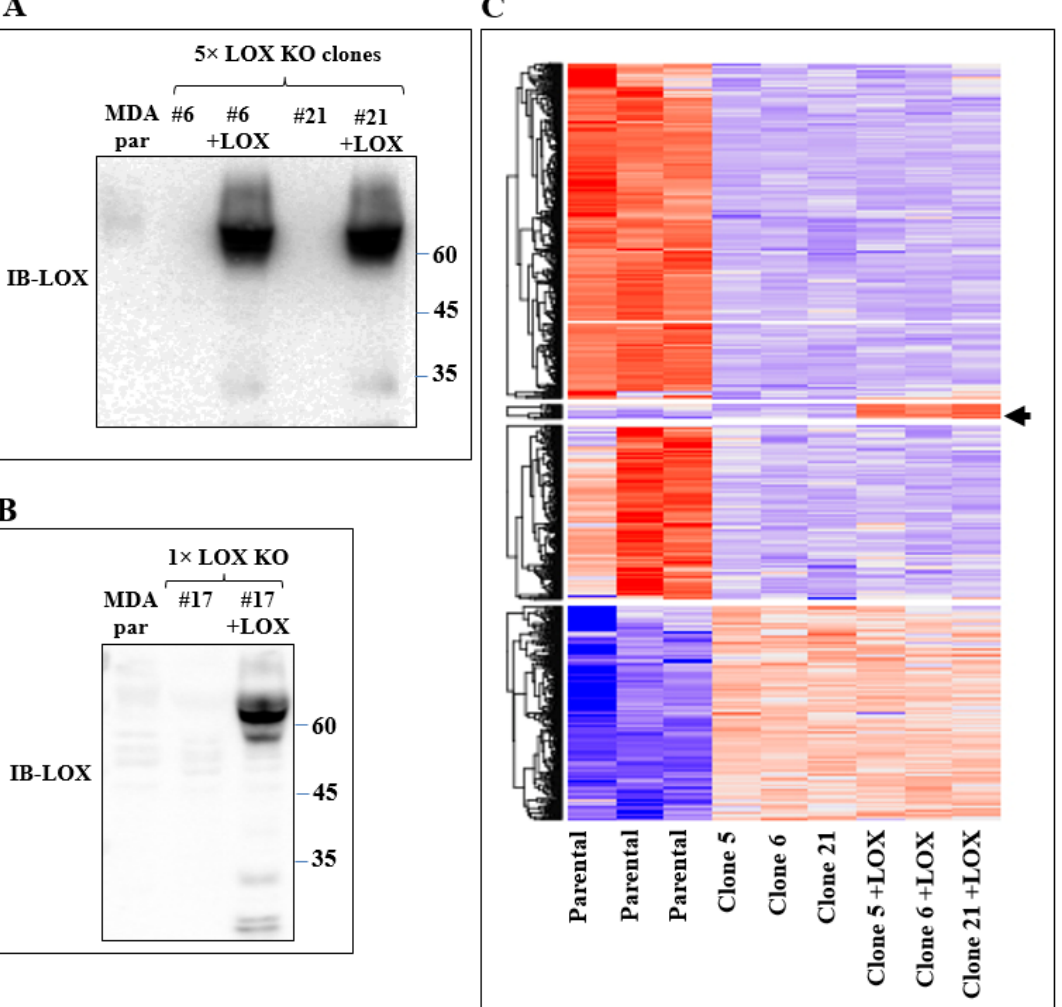
Figure 2. Re-expression of LOX in 5× knock-out clones resulted in changes in gene expression. ( A ) Western blot analysis using anti-LOX antibodies of equal volumes of conditioned medium of confluent MDA-MB-231 cells (MDA par), clone 6 and clone 21 cells and of these cells following LOX cDNA re-expression. ( B ) Western blot analysis using anti-LOX antibodies of equal volumes of conditioned medium of confluent MDA-MB-231 cells (MDA par) and clone 17 cells and of these cells following LOX cDNA re-expression. ( C ) Heat map showing color-coded expression levels of differentially expressed genes in three different plates of parental MDA-MB-231 cells, in three different 5× knock-out clones (clones 5, 6 and 21) and in these knock-out clones after re-expression of full-length LOX cDNA. The LOX cDNA did not contain epitope tags. Arrow points to a group of genes whose expression was either unchanged or inhibited following the 5× knock out but whose expression was upregulated following re-expression of the LOX cDNA.